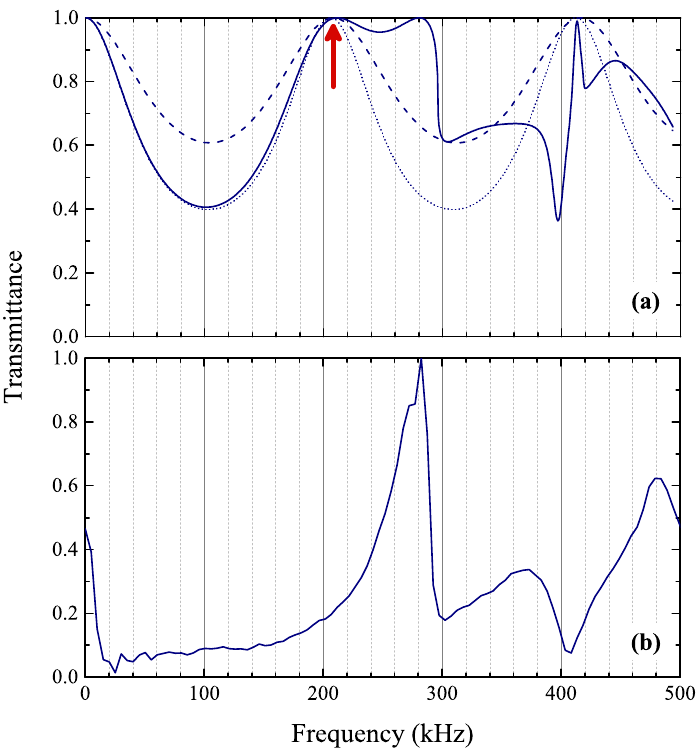
Figure 4. ( a ) calculated transmittance (solid line) of a plane acoustic wave through a ( 001 ) layer of D5N35 touching spheres ( a = d = 5 mm), immersed in water. With dashed (dotted) line we show the calculated transmittance of such a wave through an effective, homogeneous fluid plate of thickness D = 0.7 a ( D = a ) with elastic parameters ρ = 2120 kg/m 3 ( ρ = 2020 kg/m 3 ) and c = 1456 m/s ( c = 2060 m/s). The red arrow indicates the position of the first FP resonance; and ( b ) the corresponding measured transmitted pressure of a (001) layer of spheres excited by an immersion transducer